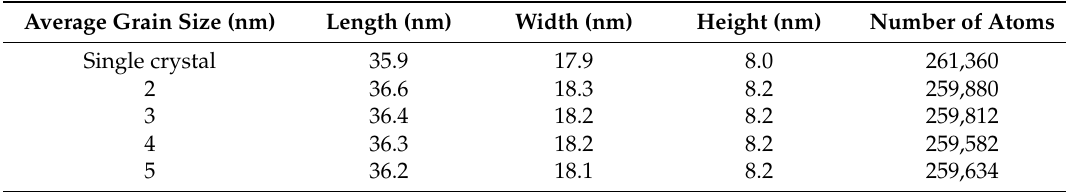
Table 1. Dimensions of single-crystalline silicon and polycrystalline silicon with different average grain